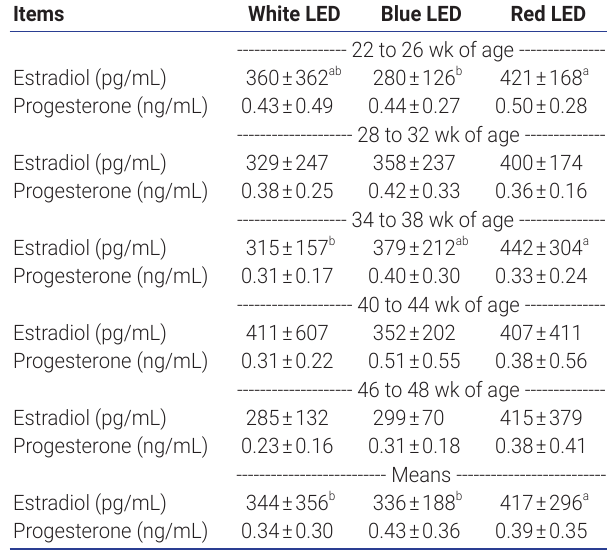
Table 9. The blood hormone levels of Brown Tsaiya ducks in differ- ent treatment groups